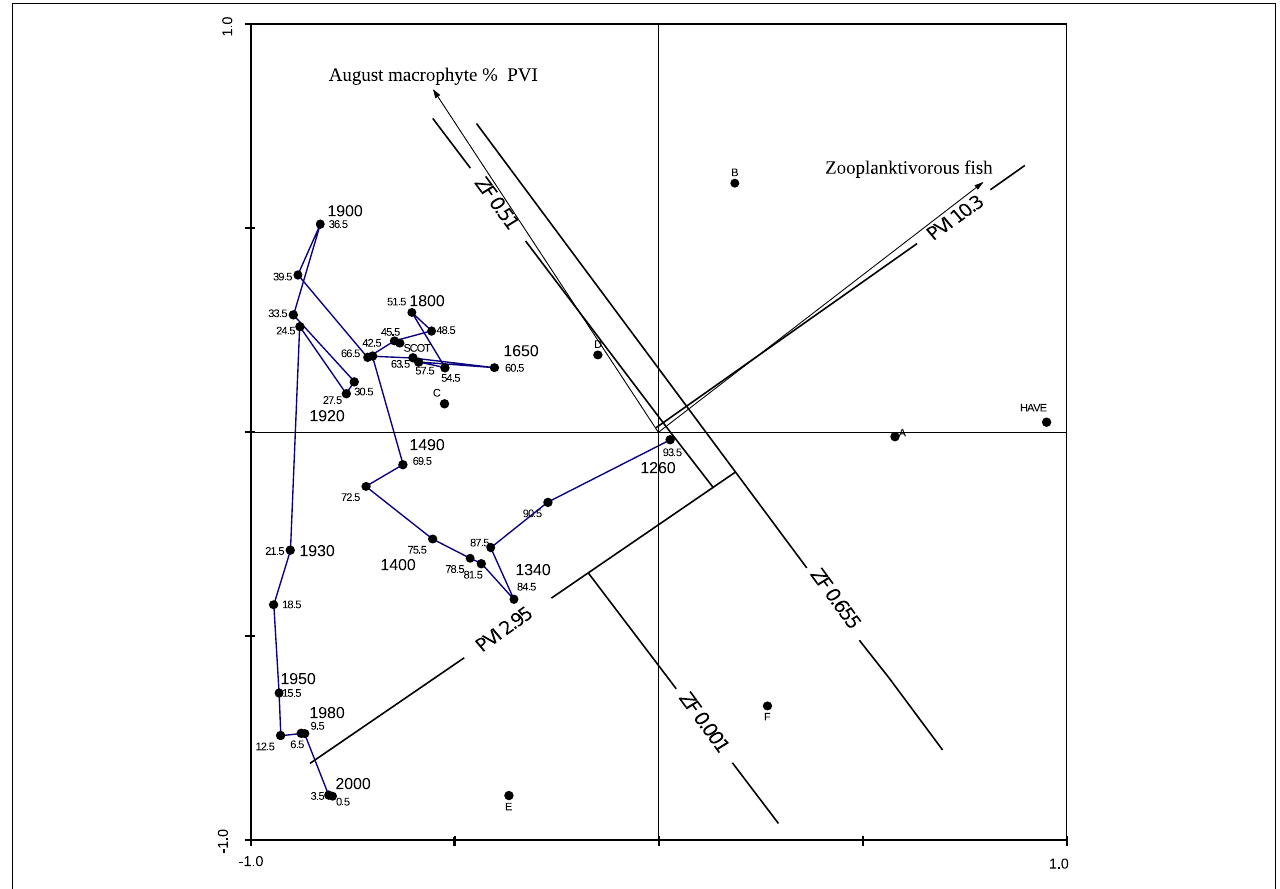
FIGURE 6 | Cladoceran-inferred August plant volume infestation and zooplanktivorous fish abundance of CUNS2 sample depths